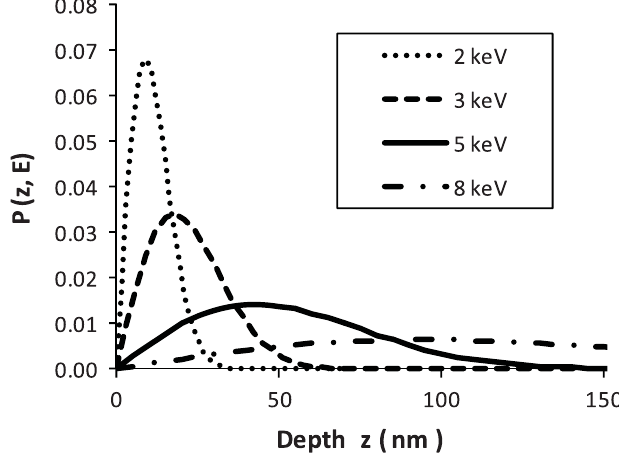
FIG. 6. Makhov profiles of positron penetration in niobium for different beam energies.